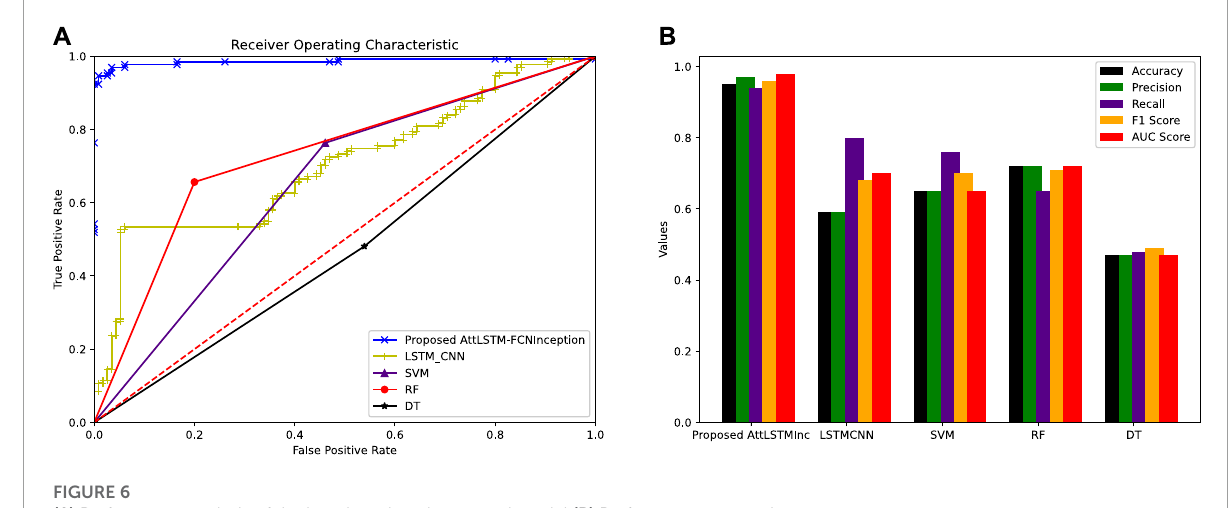
FIGURE 6 (A) Performance analysis of the benchmark and proposed model (B) Performance